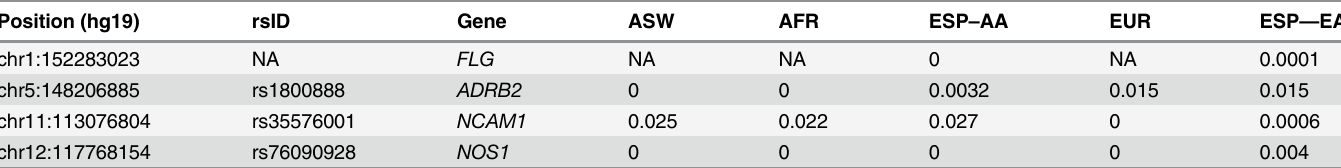
Table 7. Minor allele frequencies of four nonsynonymous variants associated with asthma following severe RSV bronchiolitis in the ASW, AFR, and EUR populations from the 1000 Genomes Project, and in European (EA) and African Americans (AA) from the Exome Sequencing Project